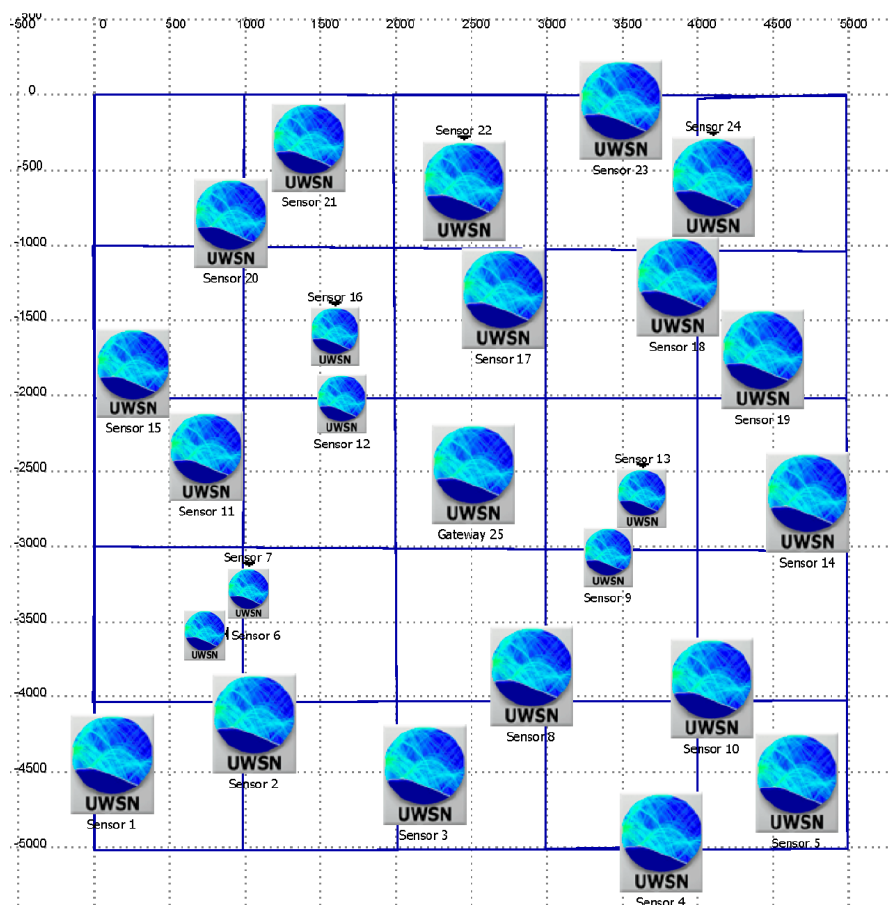
Figure 4. Network deployment